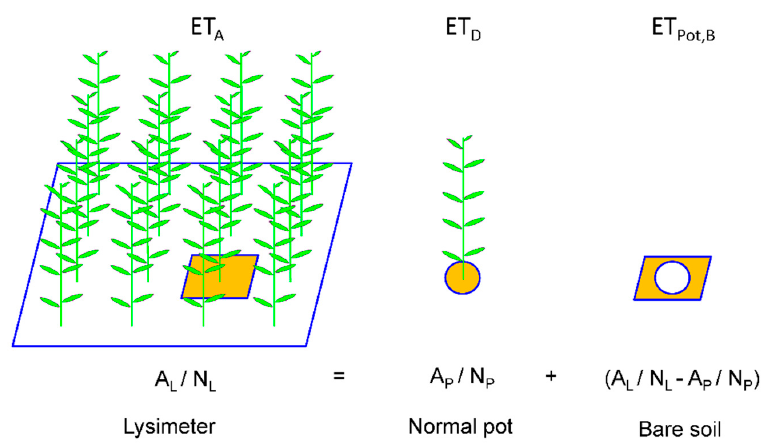
Figure 3. A schematic sketch of corrected pot evapotranspiration (ET) values based on representative areas per plant. N L and A L denote the number of plants and the soil surface area, respectively, for a lysimeter. N P and A P denote the number of plants and the soil surface area, respectively, for a pot. ET A is the corrected ET for pots based on the representative area for each plant. ET D is the corrected ET for pots based on the mean crop density level found for lysimeters. ET Pot,B is the measured ET value for pots without